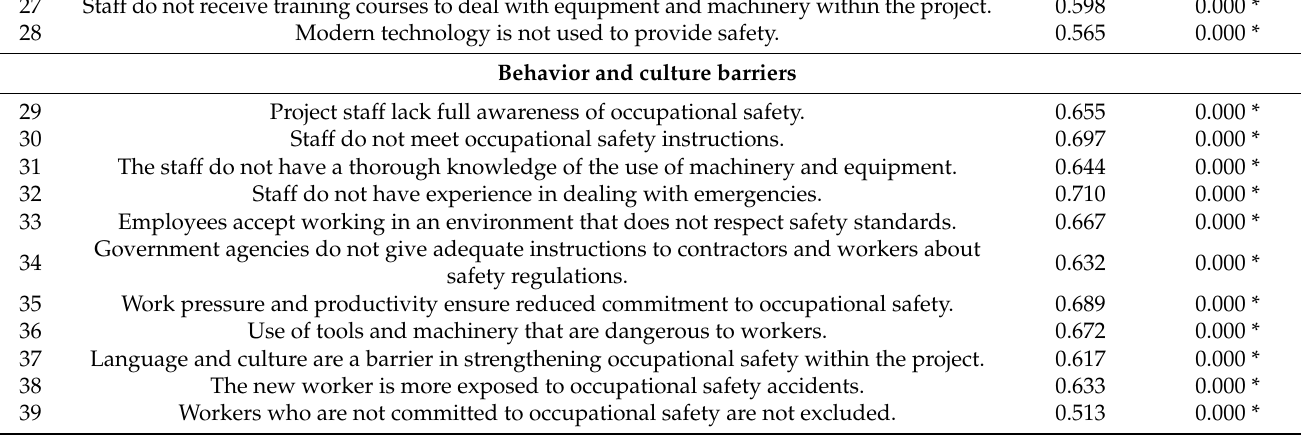
Behavior and culture